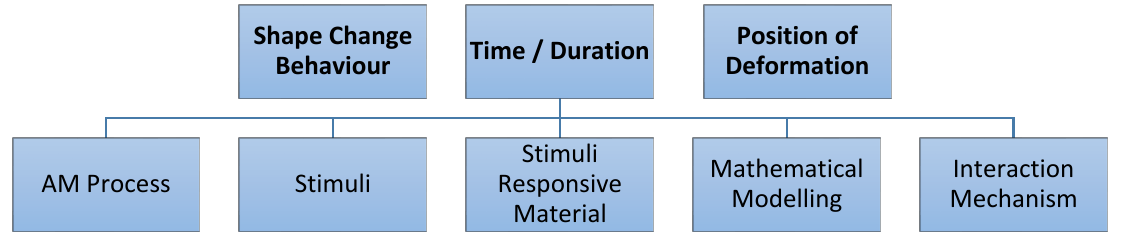
Figure 2. Conceptual framework for 4D printing (4DP) [10], adapted from Momeni et al. [8].